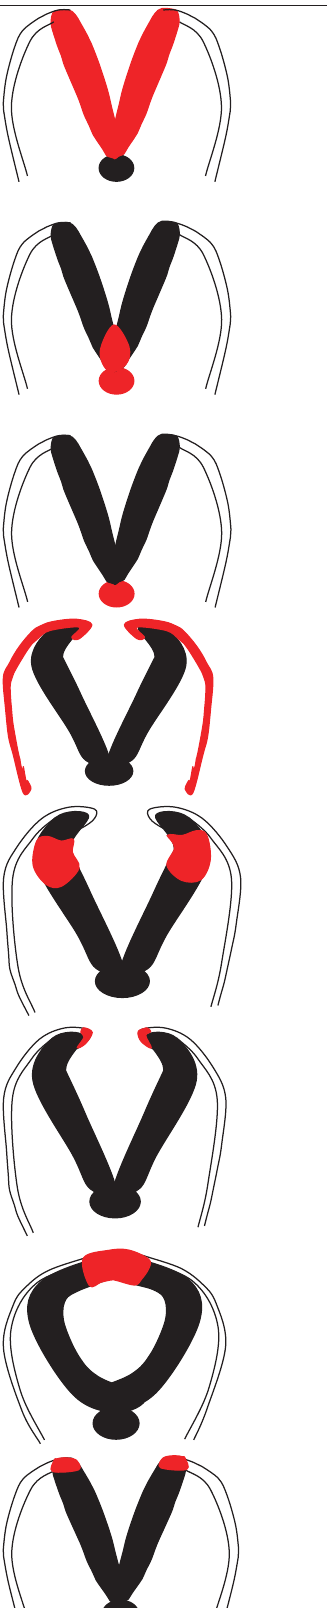
Neural tube structure Genes expressed